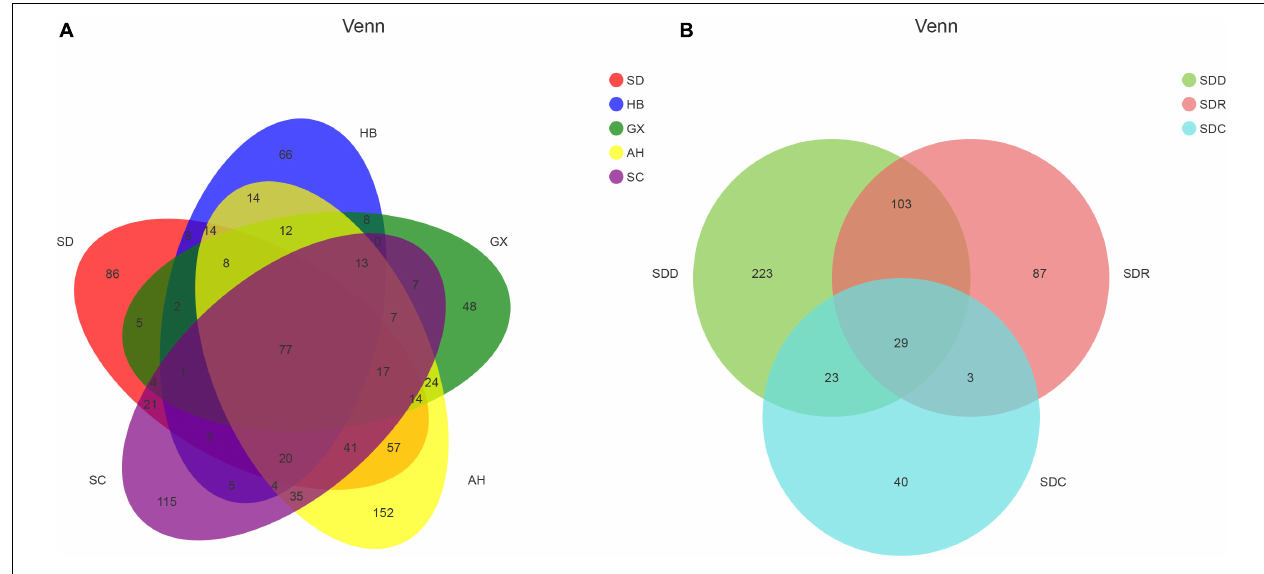
FIGURE 3 | Fungal composition in CF samples from different collection areas at the (A) phylum level, (B) class level, (C) family level, and (D) genus level.